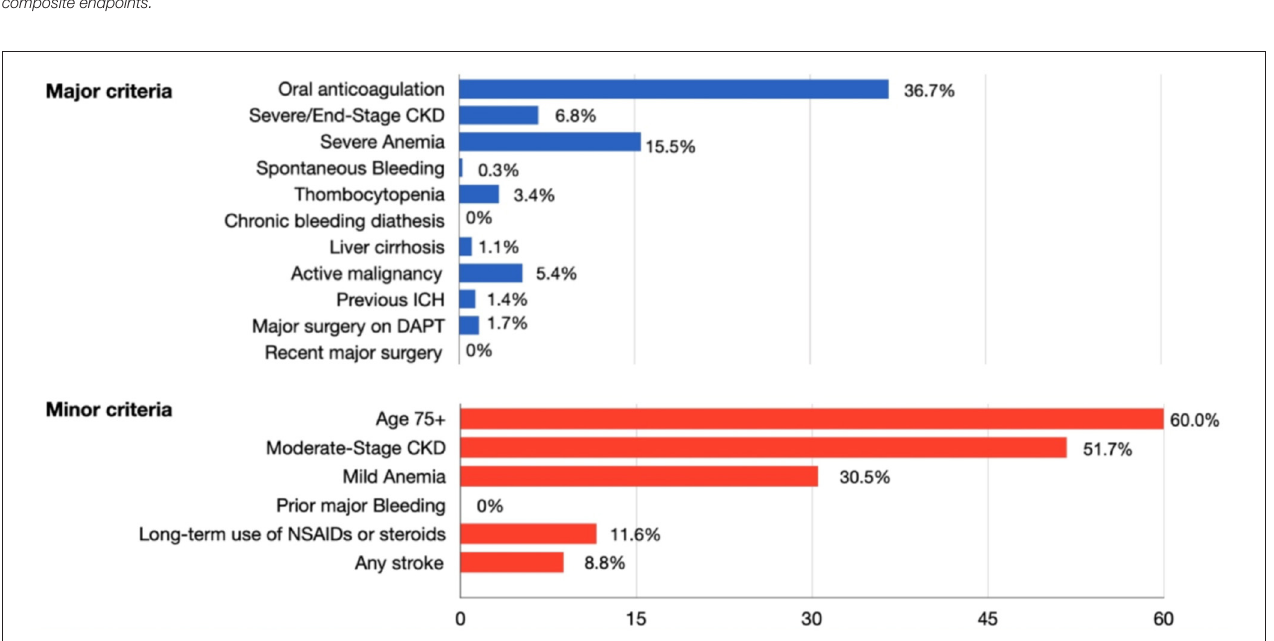
bleeding (10.5 vs. LBR 1.5%, p < 0.01). Interestingly,